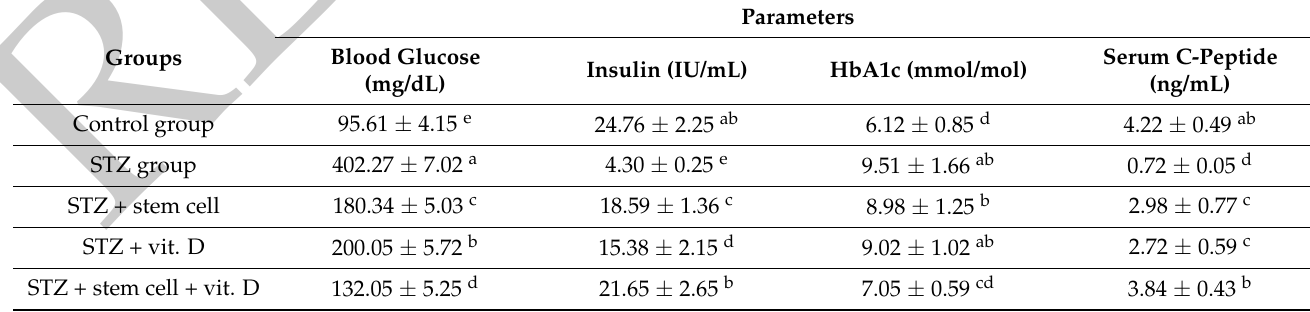
Data are presented as the mean ± SE. STZ: diabetic group, vit. D: vitamin D. Letters carrying different symbols are significant and assigned alphabetically. The values with the same letters are not significantly different, and the data with different letters are significantly